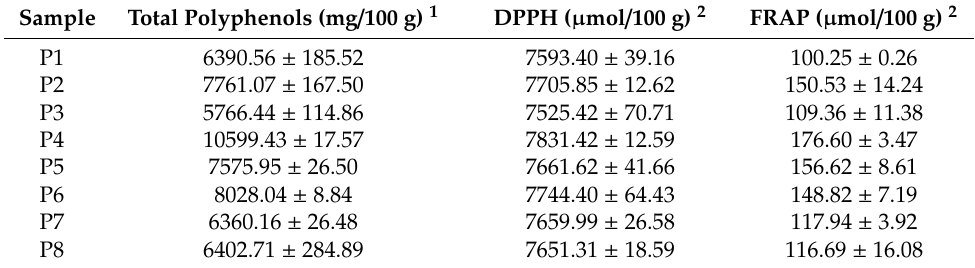
Table 3. The content of total polyphenols and antioxidant activity (DPPH and FRAP values) of ethanol extracts of pomegranate (Punica granatum L.) peels (PPEs). Result are given as a mean value ± standard deviation